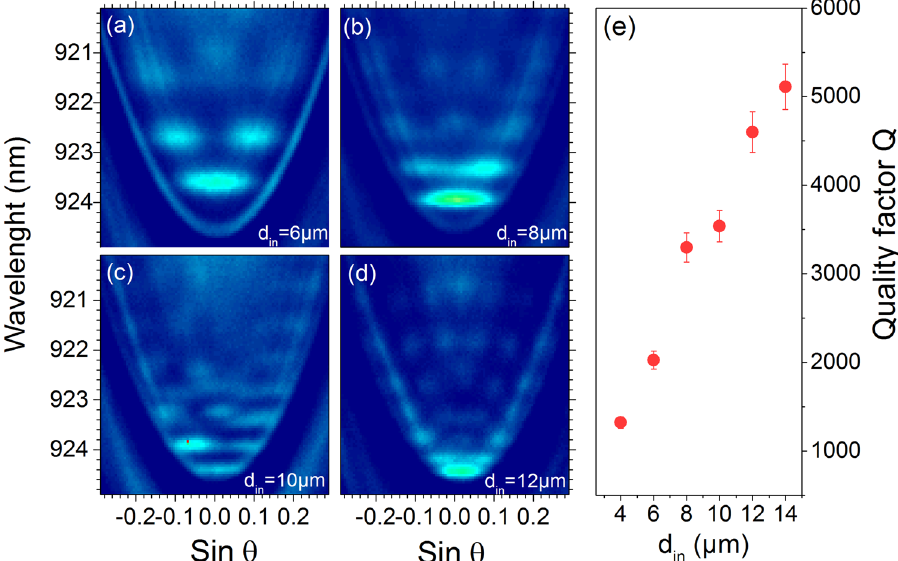
Figure 5. ( a – d ) Experimental dispersion relations of the emission recorded for rings with inner diameter d in of 6, 8, 10, and 12 µ m. ( e ) Variation of the confined super Tamm fundamental mode quality factor as a function of d in